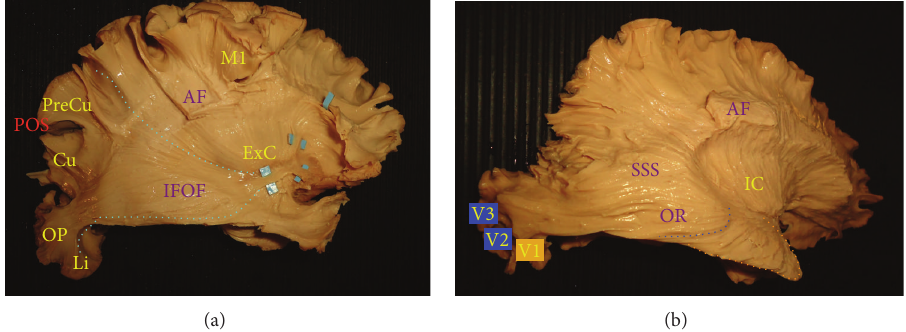
Figure 2: (a) Lateral view of the right hemisphere once the MLF and the insular cortex have been resected. The Inferior fronto-occipital fasciculus (IFOF) is completely exposed at the level of the external capsule (ExC). The posterior originating branches run from precuneus (PreCu), cuneus (Cu), occipital pole (OP) region, and lingula (Li) within the sagittal stratum of Sachs (SSS) towards the frontal lobe. Light blue dotted lines represent the spatial distribution of the posterior termination of the IFOF. (b) After the resection of the IFOF on the lateral surface of the brain, the optic radiation (OR) is exposed within the deep part of the SSS. According to Alvarez et al. [35] the dark blue line represents the anterior margin of the dorsal component of the OR, which will end at the level of the dorsal portion of extrastriate visual cortices (V2 and V3). The orange dotted line represents the anterior margin of the ventral component of the OR fibres that runs inferiorly and lateral with respect to the lateral ventricle to end at the level of primary visual cortex (V1). M1: primary motor cortex (precentral gyrus); IC: internal capsule; AF: arcuate fasciculus fibres left as superficial landmark .